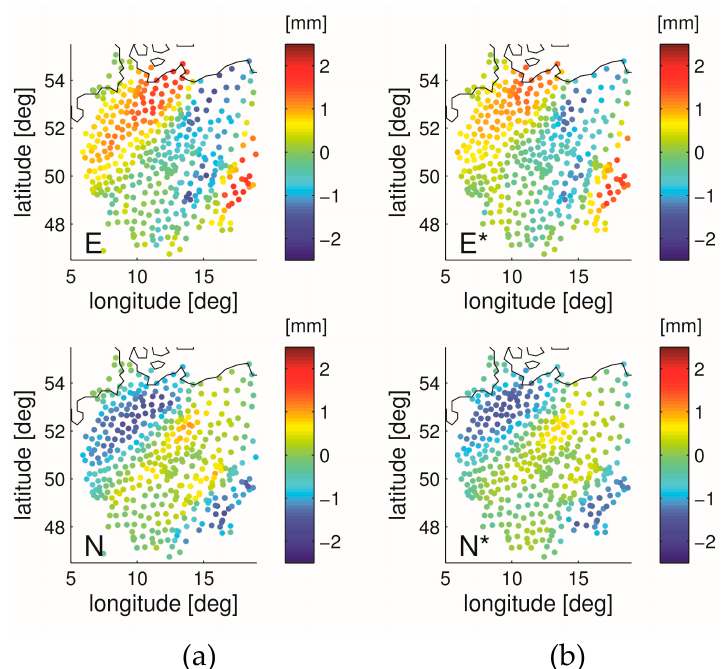
Figure 2 . The left panels ( a ) show the wet east (E) and north-gradient (N) coefficient and the right panels ( b ) show the approximation for the wet east (E*) and north-gradient (N*) coefficient (2 July 2017, 12 UTC). The approximations for the wet gradient coefficients are obtained by utilizing ZWD gradients. For details refer to the text.